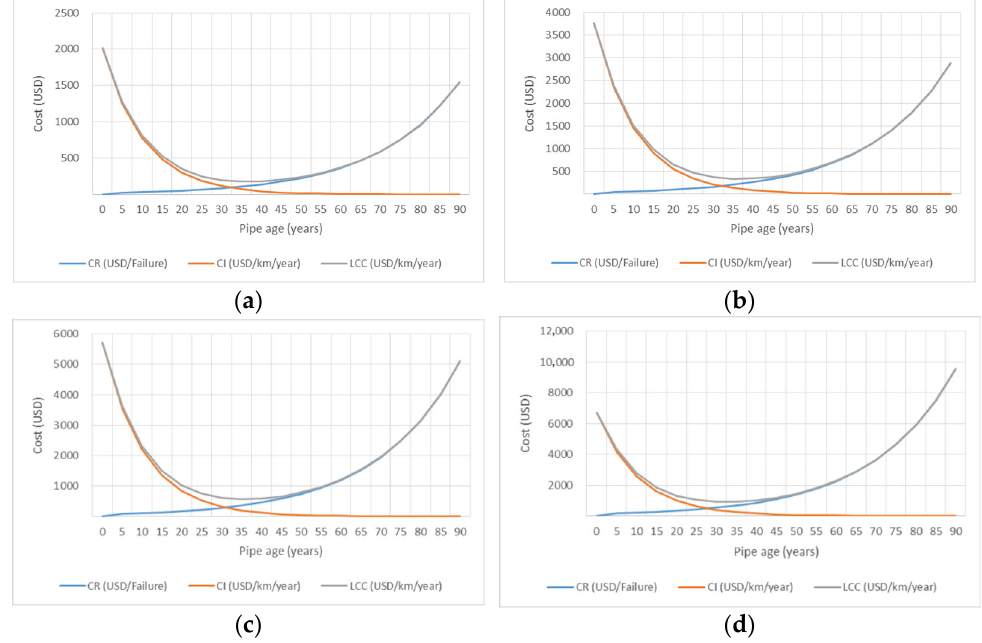
Figure 10. LCC curves of MCMC estimation. ( a ) PVC 63 mm; ( b ) PVC 90 mm; ( c ) PVC 110 mm; ( d ) PVC 150 mm.